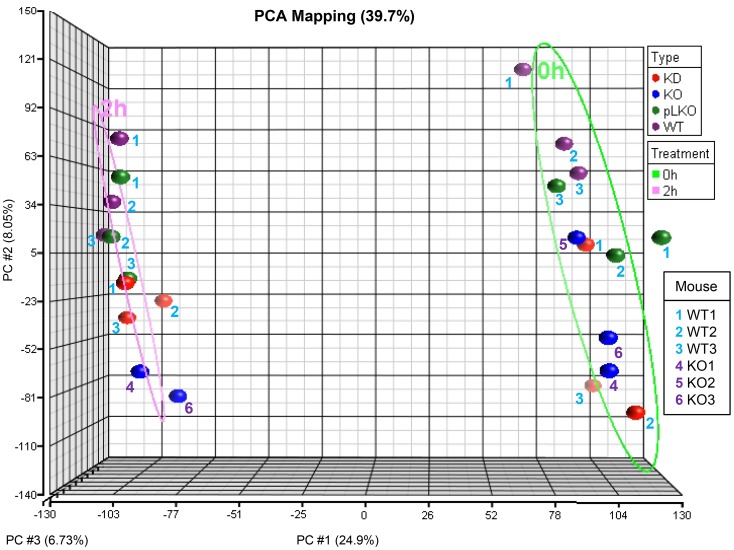
Principal component analysis of the microarrays.Each colored circle represents different cell type: NTAL KD (KD; red), NTAL KO (KO; blue), WT pLKO (pLKO; green), and WT (lilac). Each mouse from which the cells originated is identified by a colored numbers. The WT BMMCs isolated from mice 1–3 (blue numbers) were used not only as controls for NTAL KO cells, but also for obtaining NTAL KD and WT pLKO cells after lentiviral infection with NTAL shRNA or empty pLKO vector, respectively. The BMMC isolated from Lat
-/- mice 4–6 (lilac numbers) were used only as cells with NTAL KO. Treatment [Ag-activated cells (2h, pink) and nonactivated cells (0h, green)] is distinguished by ellipsoids. The arrays cluster according to the treatment groups showing separation along PC #1 and according to the type of cells showing separation along PC #2. The percentage values indicate the proportion of total variance described by each PC; PC #1 (X-axis), PC #2 (Y-axis), and PC #3 (Z-axis).